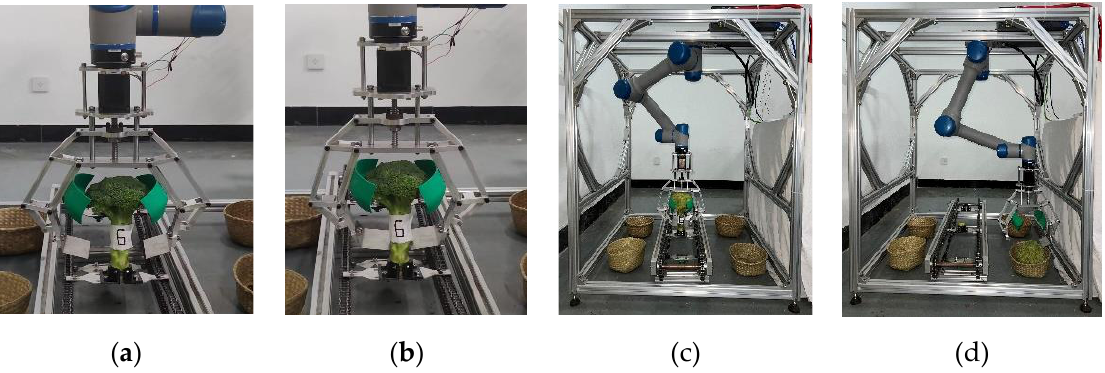
Figure 13. Experimental picking process of broccoli: ( a ) The manipulator moves closer to the broccoli; ( b ) The manipulator contacts the broccoli; ( c ) Clamping and cutting; ( d ) Broccoli is released into the harvest basket.